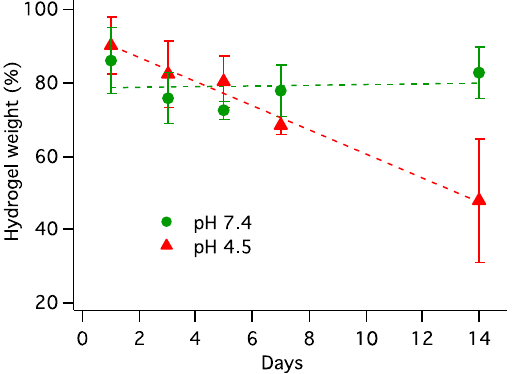
Figure 8. Weight loss of 3LM-hydrogels in pH 7.4 and pH 4.5 at 37 °C in the presence of proteinase K.